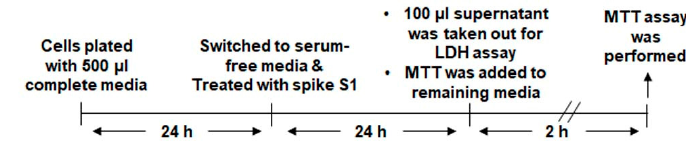
Figure 1. Time line for LDH and MTT assays.